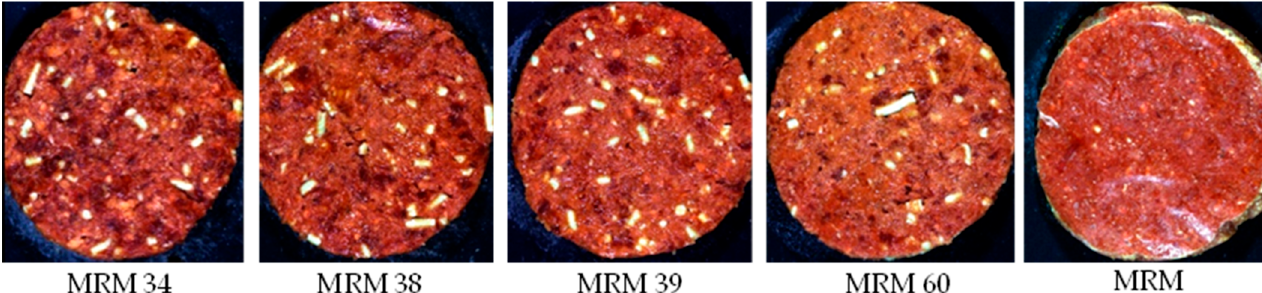
Figure 4. Digital images of the various mechanically recovered meat (MRM) percentages for Patty 4 (economy burger/econo burger/economy patty/econo patty/budget burger/econo hamburger patty/budget hamburger patty/econo meatball/econo frikkadel/Any other similar name).